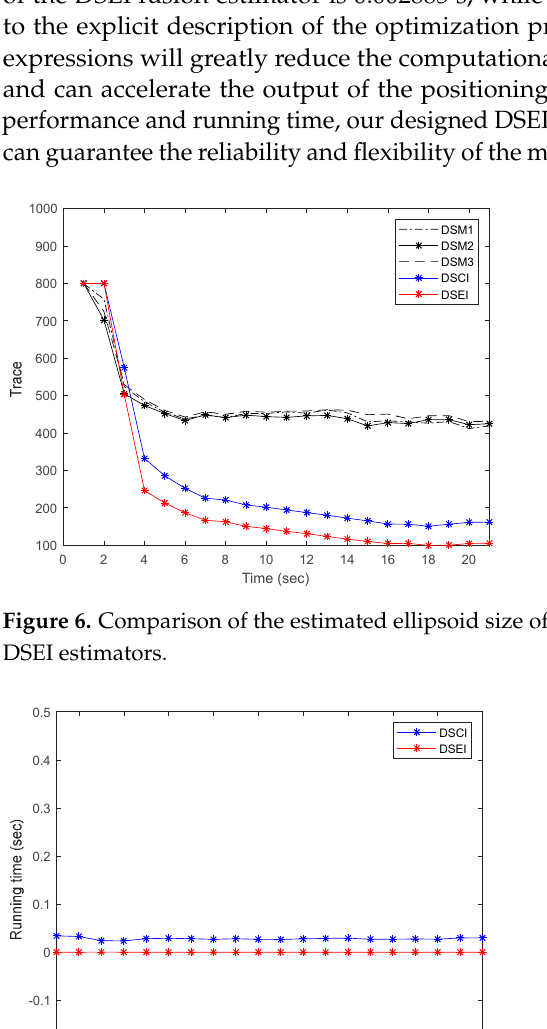
15 of 18 Figure 5. Comparison of errors in target tracking of positioning systems in the X -axis and Y -axis directions. In order to visualize the performance of the designed distributed fusion estimation, we compare the traces of the shape matrix of each estimation result. The comparison of the traces of the shape rectangles of each part of the ellipsoid is shown in Figure 6. The results show that the size of each estimated ellipsoid can converge quickly to a stable